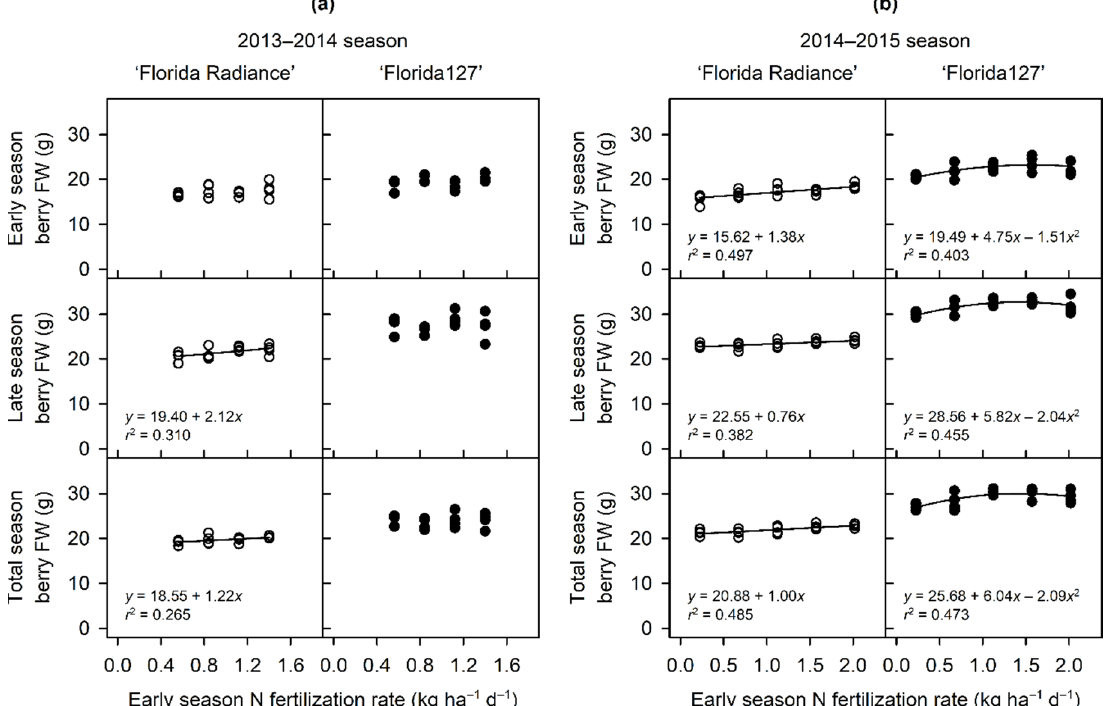
Figure 5. Average berry fresh weight (FW) responses of two strawberry cultivars to different early-season nitrogen (N) fertilization rates: ( a ) 2013–2014 growing season ( b ) 2014–2015 growing season. Treatments are as described in Tables 1 and 2. Five models were fit to each data set: linear, quadratic, exponential plateau, exponential decay, and sigmoidal models. Only the significant ( p ≤ 0.05) and best-fit model is shown for each data set. No regression line is shown when none of the models had a significant fit. Early season = November–December. Late season = January–February.